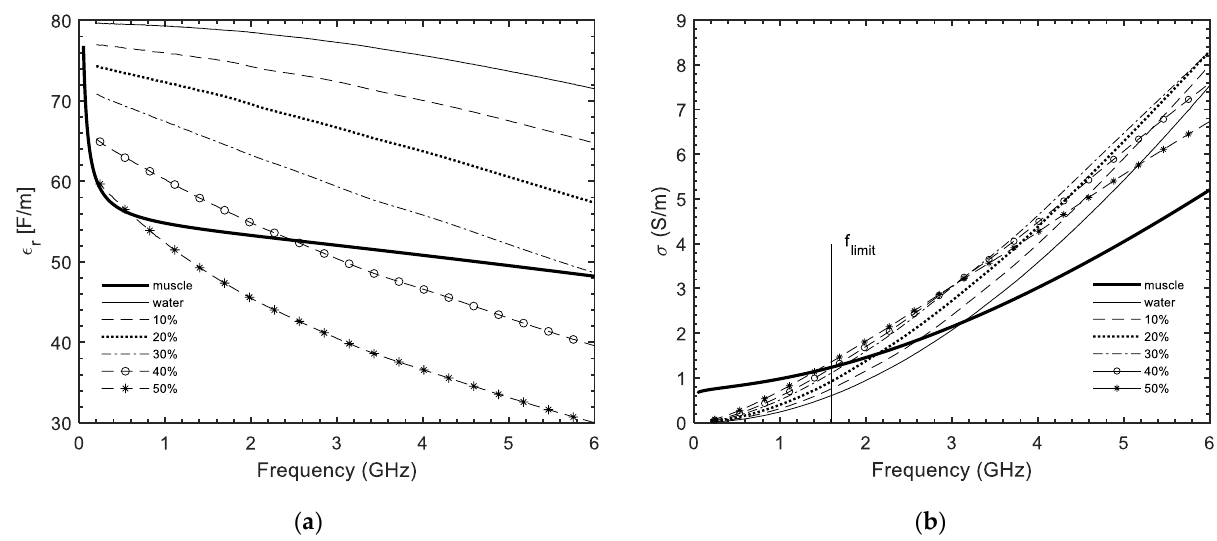
Figure 7. ( a ) Measured real part of permittivity (black lines) and ( b ) conductivity (grey lines) for different sugar concentration liquids and muscle theoretical values